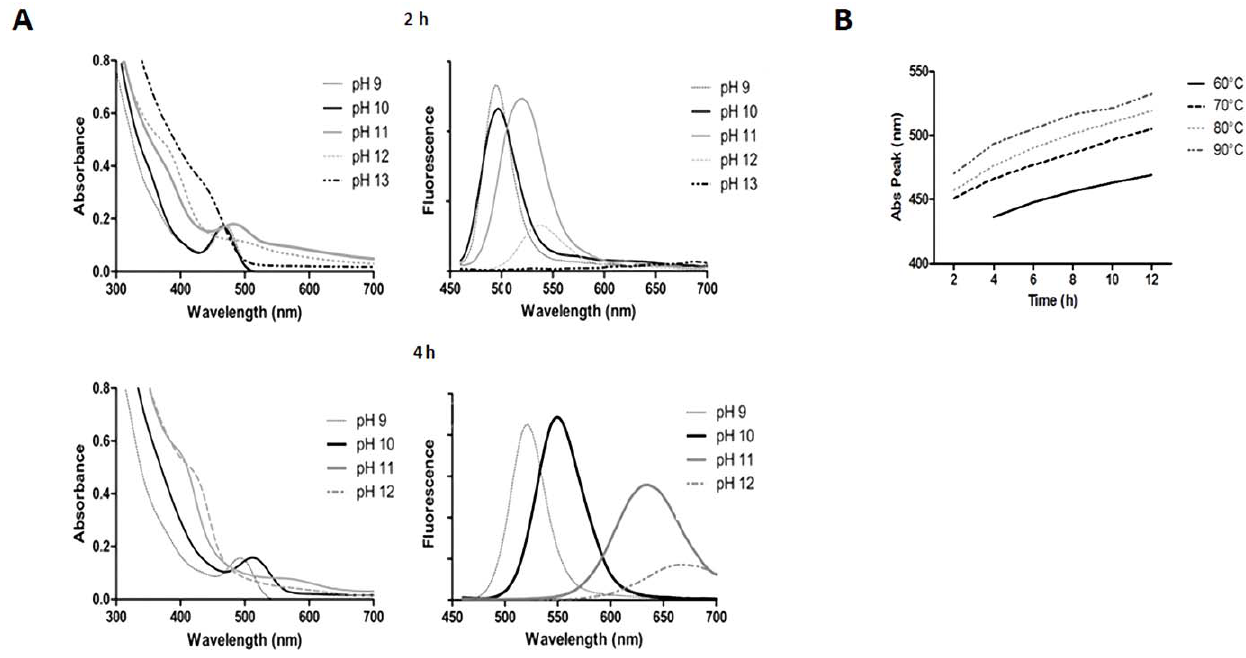
Figure 3. Absorbance and fluorescence emission spectra of CdTe-GSH QDs synthesized at different pHs at 90 6 C. A, above, CdTe-GSH QDs after 2 h; below, same CdTe-GSH QDs after 4 h. Samples prepared at pH 13 showed no fluorescence at 4 h. B, Effect of nucleation temperature on CdTe-GSH absorbance peaks measured at different times of synthesis.